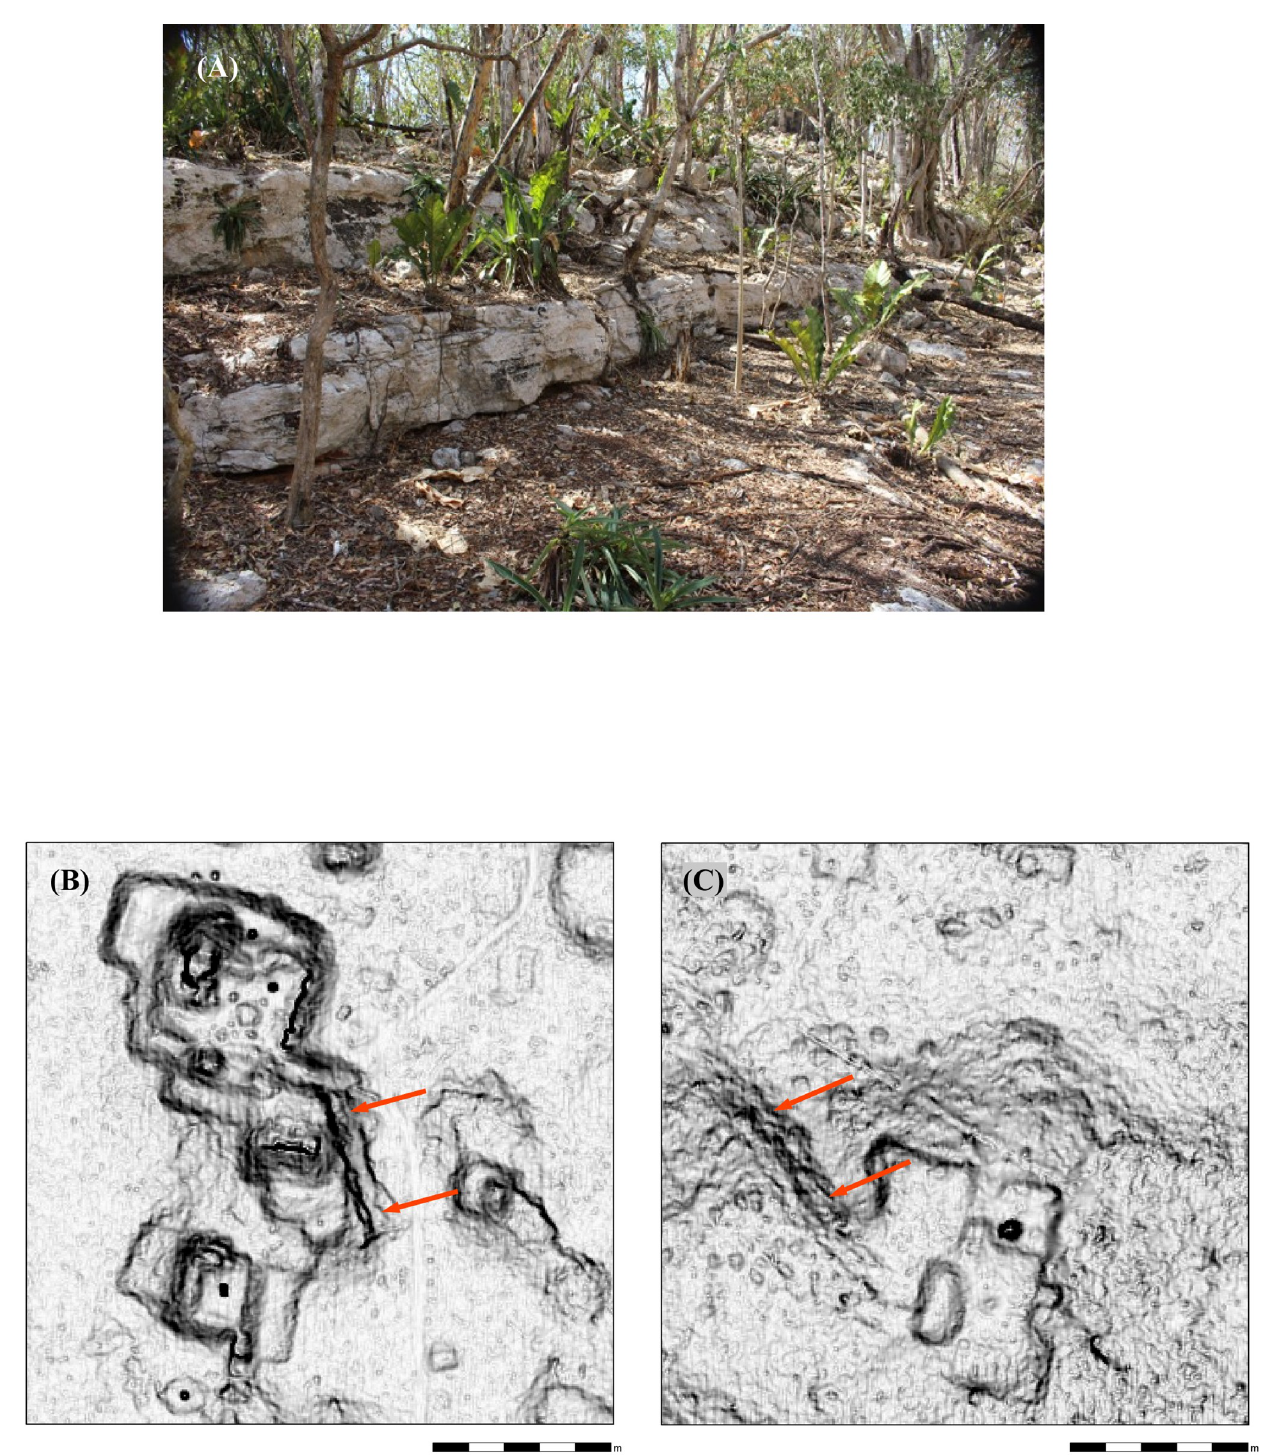
Fig 18. Evidence of stone quarrying visible in lidar imagery. (A) a section of the ledge quarry at Kom. (B) the Kom ledge quarry in the lidar imagery, marked with arrows. Note proximity to palace group. (C) a ledge quarry at Muluchtzekel, marked with arrows.